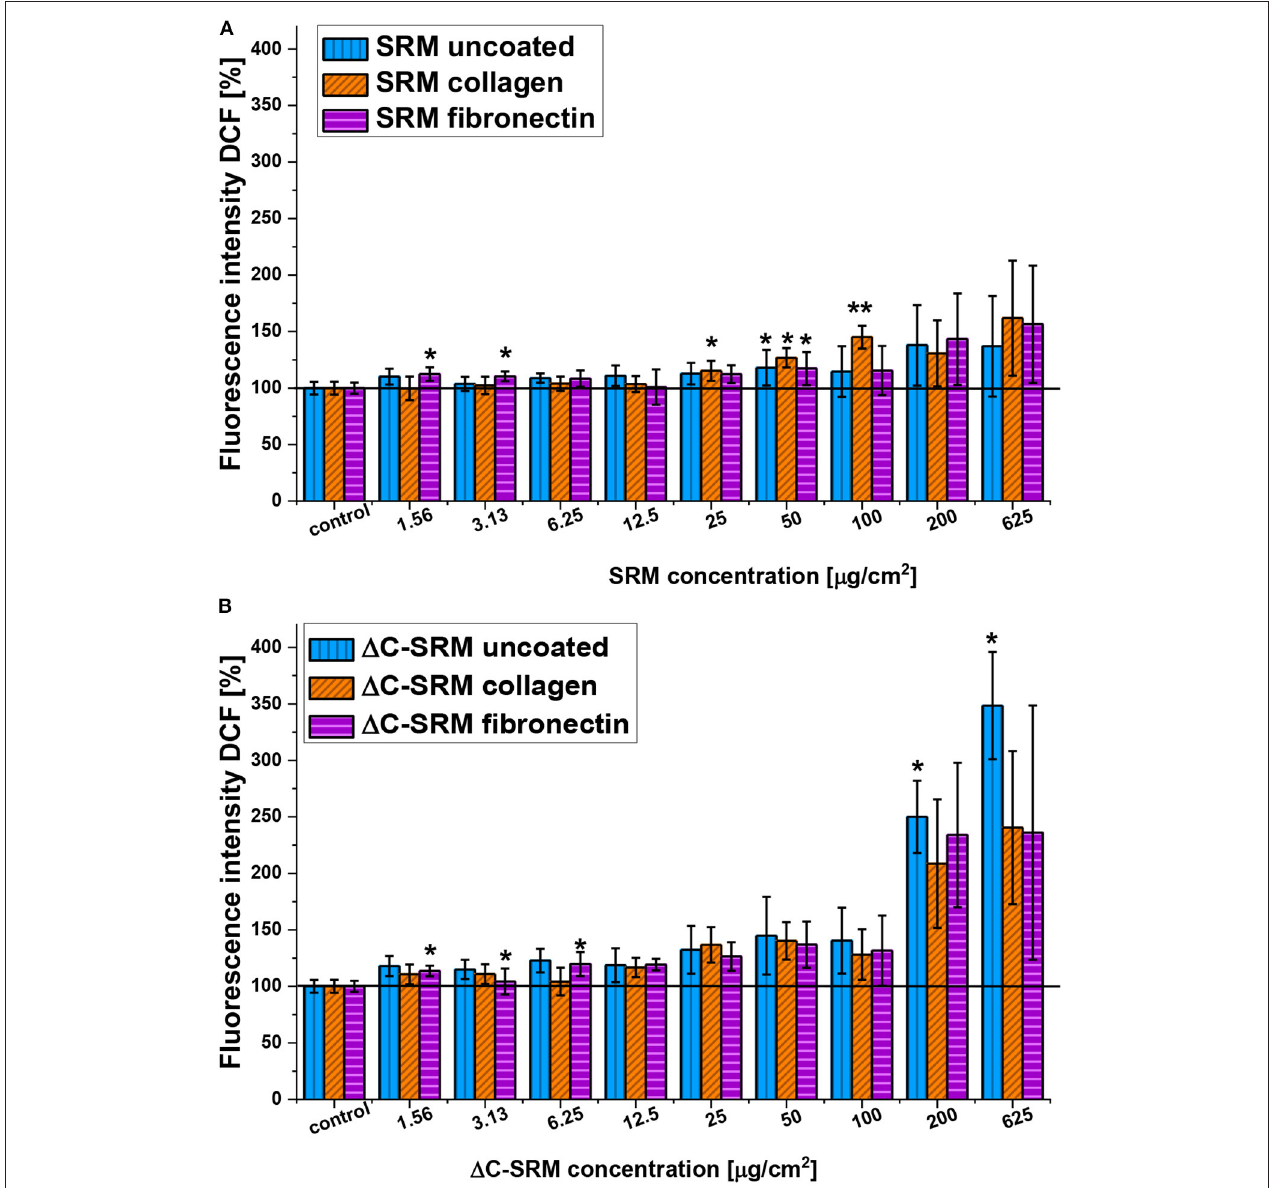
FIGURE 3 | The reactive oxygen species (ROS) production in A549 cells after 24-h incubation with particulate matter (PM) suspensions of different concentrations covering plates either uncoated or coated with fibronectin/collagen measured using 2,7-dichlorodihydrofluorescein diacetate ( A , SRM; B , 1 C-SRM) (exposure method 2),* p < 0.05, ** p <